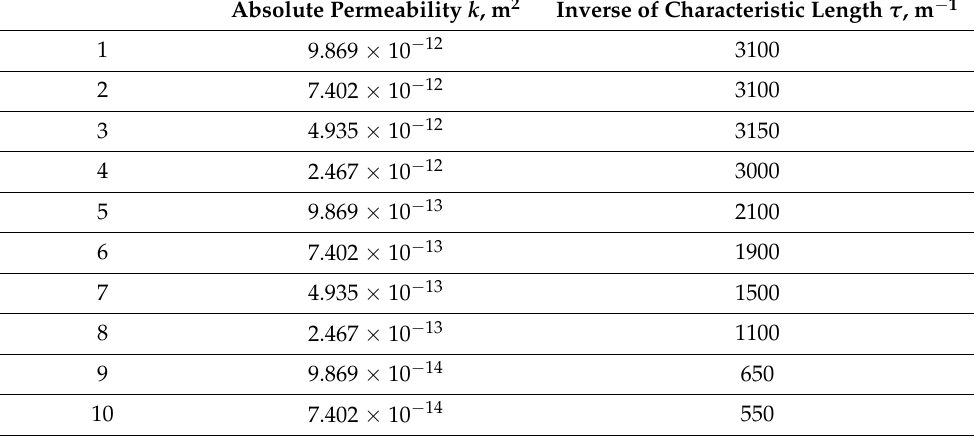
Table 2. Parameter of Barree – Conway model (Figure 2).